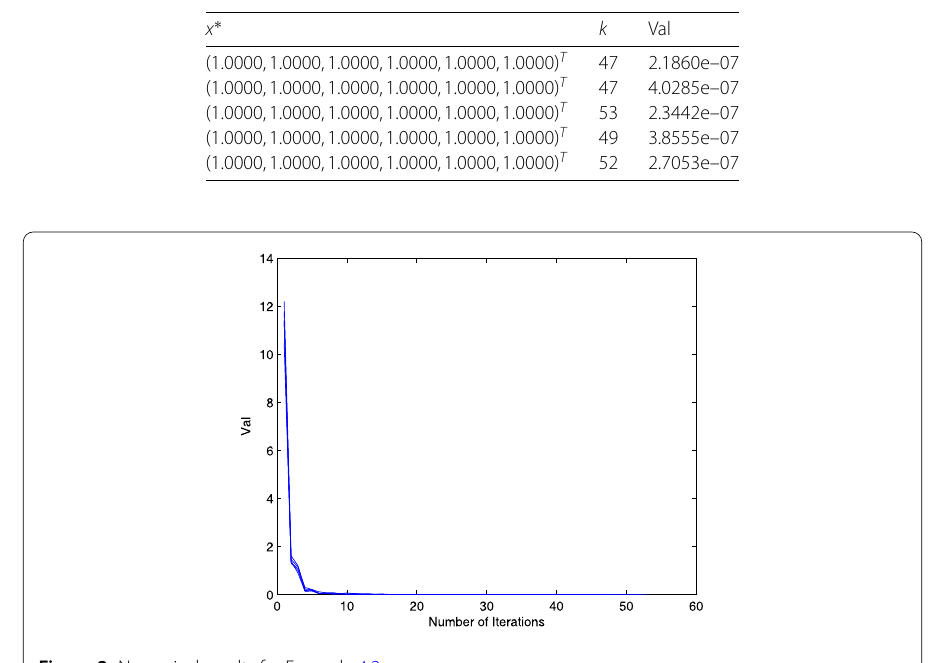
Figure 2 Numerical results for Example